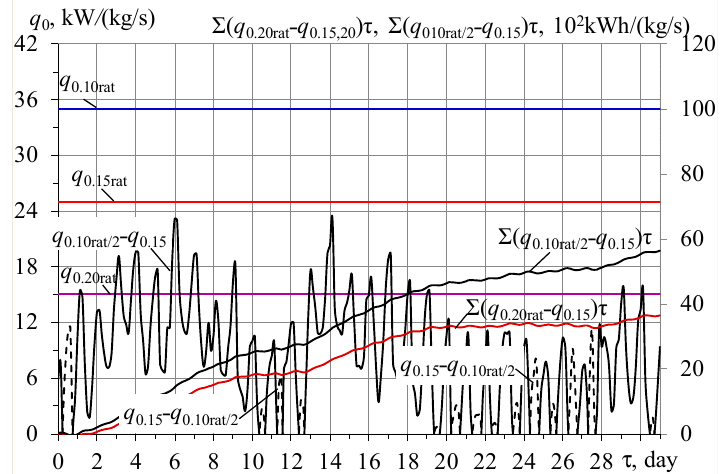
Figure 8. Actual values of rational refrigeration capacity q 0.10rat/2 exceedance q 0.10rat/2 − q 0.15 above q 0.15 and its deficit q 0.15 − q 0.10rat/2 , summarized monthly refrigeration energy ∑ q 0.10rat/2 τ exceedance ∑ ( q 0.10rat/2 − q 0.15 ) τ over q 0.15 , and summarized refrigeration ∑ q 0.20rat τ exceedance ∑ q 0.20rat.ex15 τ = ∑ ( q 0.20rat − q 0.15 ) τ over q 0.15 .